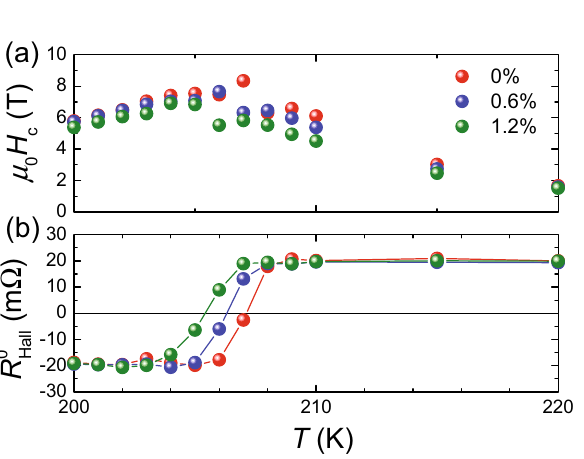
Figure 3. Temperature T dependence of ( a ) coercivity H c and ( b ) Hall resistance at μ 0 H z = 0 T ( R the anomalous Hall measurement performed at ( c ) 200 K and ( d ) 300 K.